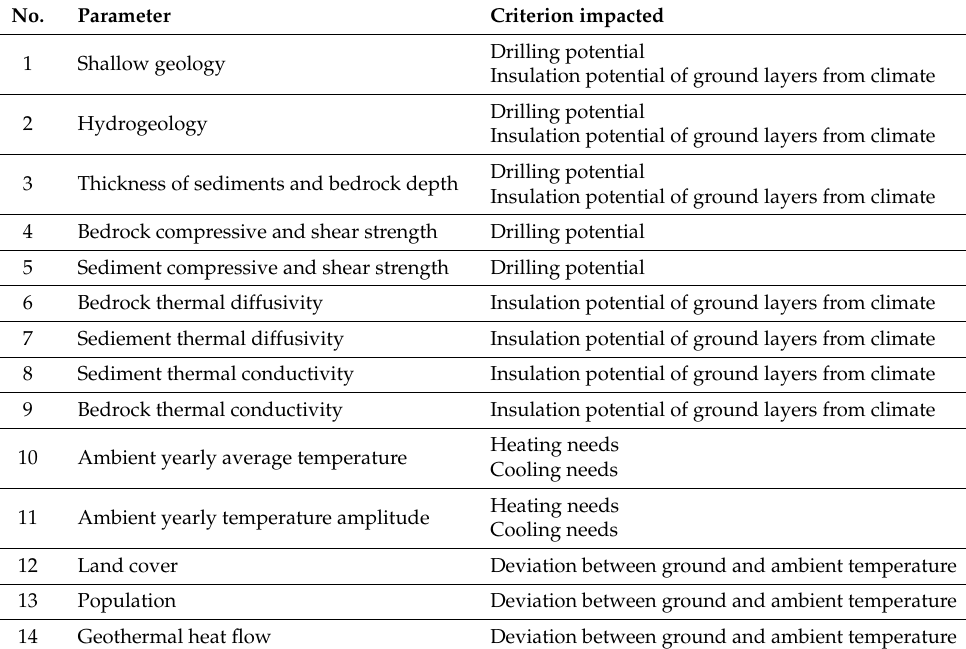
Table 1. List of parameters used and the criteria